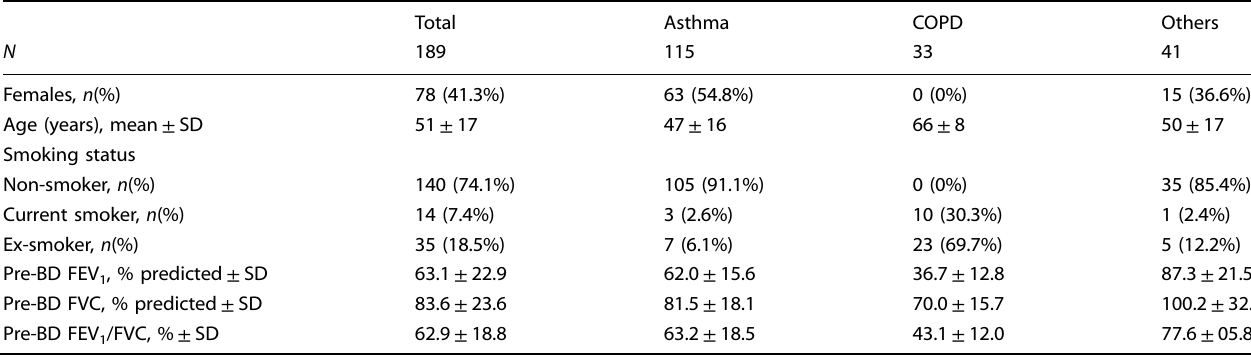
Table 1. Patient characteristics